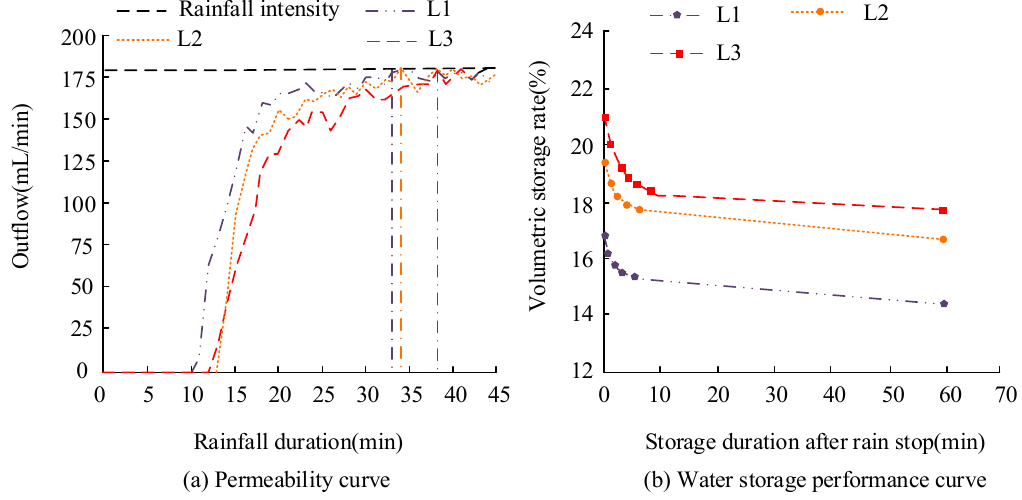
Figure 5. Infiltration and storage performance curve of materials with different multi-layer single- particle size gradation.